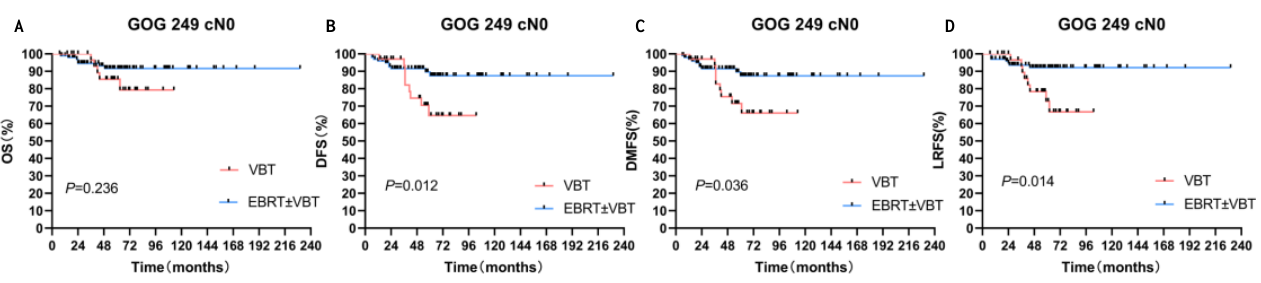
Figure 4. Subgroup analysis in the GOG249 HIR cohort. ( A ) OS for two RT modes. ( B ) DFS for two RT modes. ( C ) DMFS for two RT modes. ( D ) LRFS for two RT modes.